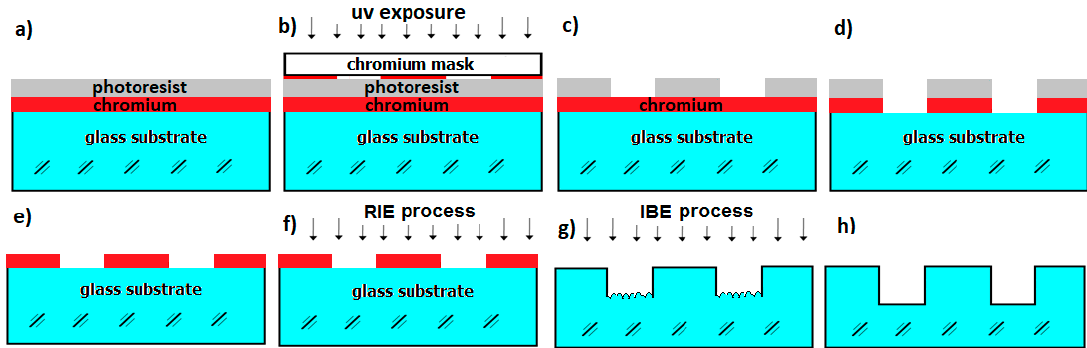
Figure 4. Principle of lithographic structuring of FBS glass substrate: ( a ) Deposited 100 nm chromium layer and 1.4 µm photoresist layer; ( b ) Photolithographic contact UV-exposure using chromium coated mask; ( c ) Developed photoresist layer; ( d ) Wet chemical etched chromium layer; ( e ) Removed photoresist structure; ( f ) RIE structuring of glass substrate; ( g ) Reduction of nano roughness using IBE process; ( h ) Final structured FBS element.